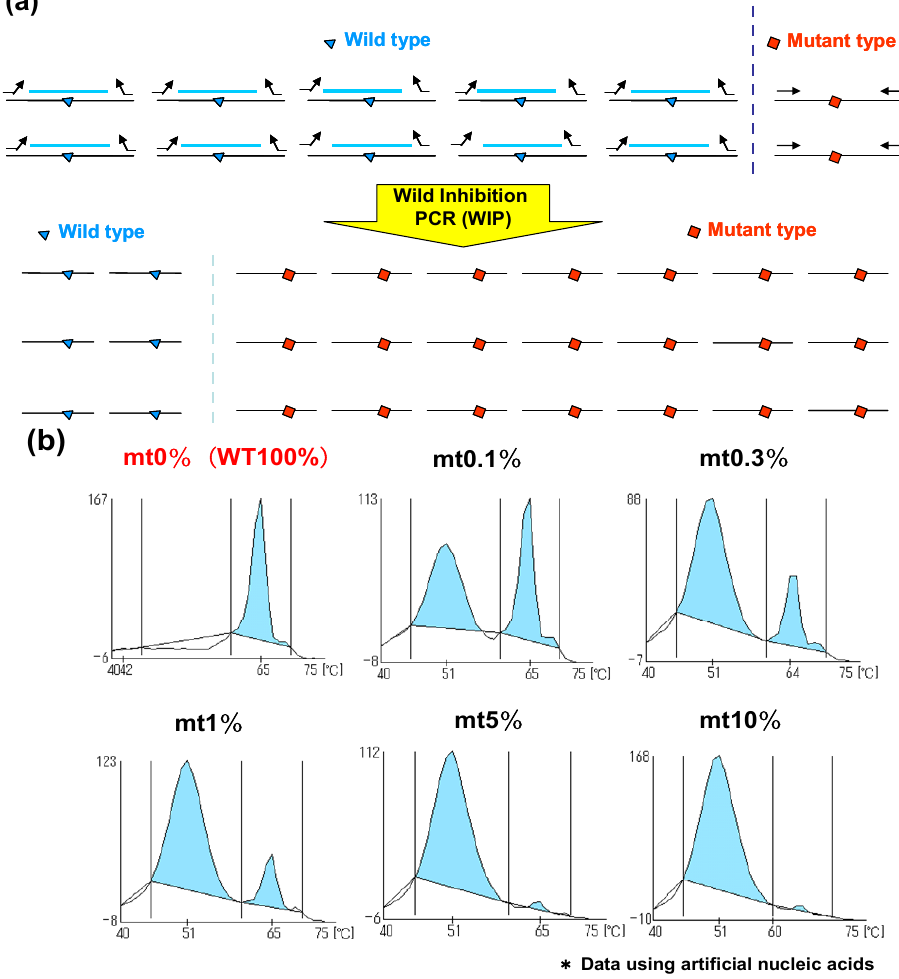
Figure 3. Measurement principle—Wild Inhibition PCR (WIP). ( a ) DNA fragments from the wild type as well as primers for the wild and mutant types are mixed with plasmid DNA. Amplification of wild type sequence is inhibited by this DNA fragment. ( b ) Measurement results of the detection of in-frame deletion in EGFR exon 19 using WIP-QP